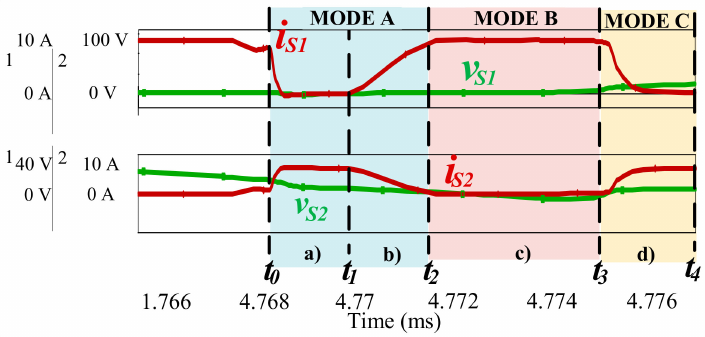
Figure 3. Key waveforms: voltage and current in S 1 and S 2